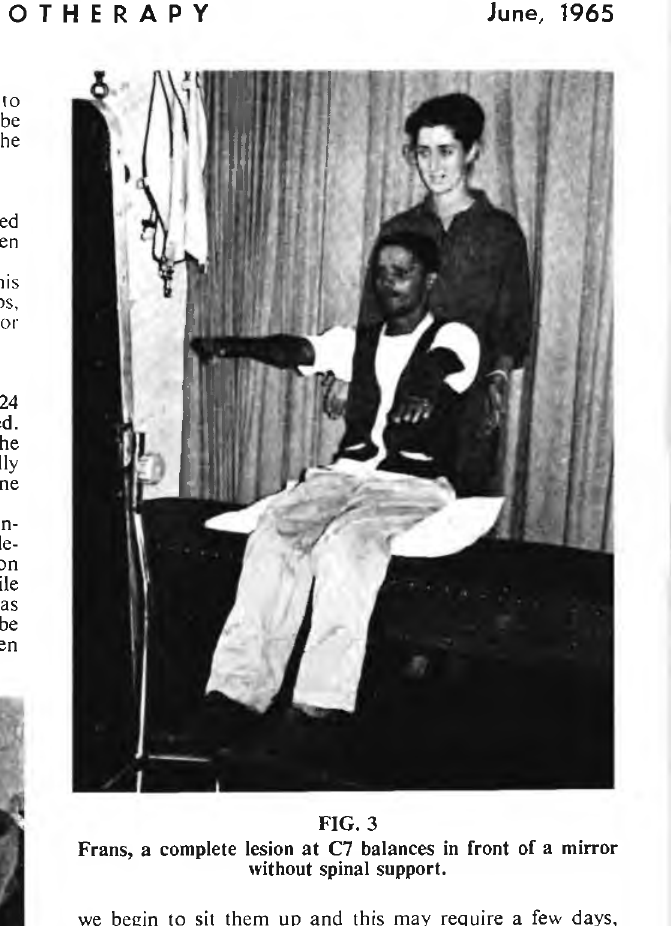
FIG. 3 Frans, a complete lesion at C7 balances in front of a mirror without spinal